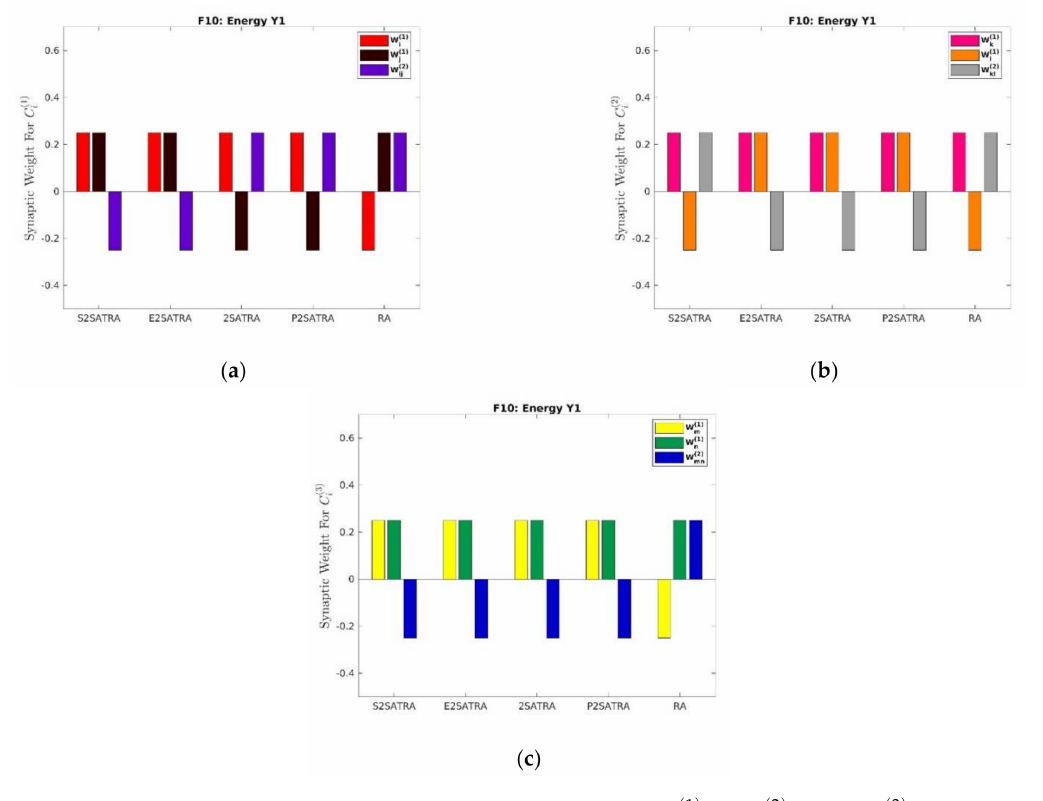
( 1 ) ( 2 ) ; ( b ) C and ( c ) C i i